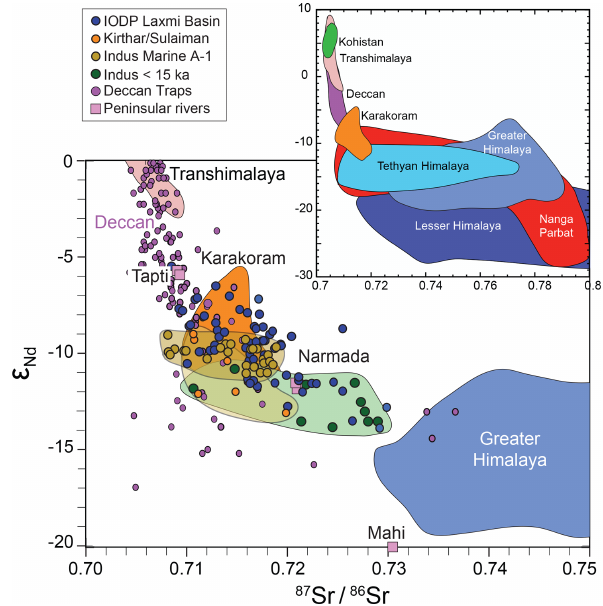
Figure 4. Diagram showing the Nd and Sr isotopic compositions of sediments recovered from the Laxmi Basin drill sites and Indus Ma- rine A-1 compared to the major possible source terrains. Inset map shows the full isotopic range of the source ranges. Data from the Deccan Plateau compiled from Georoc (http://georoc.mpch-mainz. gwdg.de/georoc/, last access: 16 November 2015). Pink squares show the composition of selected Indian Peninsula rivers (Goswami et al., 2012). Compositions for the Indus Delta since 15ka are from Clift et al. (2010). Data from the Kirthar and Sulaiman ranges are from Zhuang et al. (2015). Transhimalaya data are from Rolland et al. (2002), Singh and France-Lanord (2002), and Khan et al. (1997). Greater Himalayan data are from Ahmad et al. (2000), Deniel et al. (1987), Inger and Harris (1993) and Parrish and Hodges (1996). Karakoram data are from Crawford and Searle (1992) and Schärer et al.